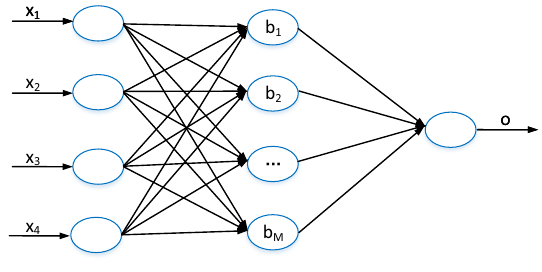
Figure 12. The structure of single-hidden layer feedforward neural